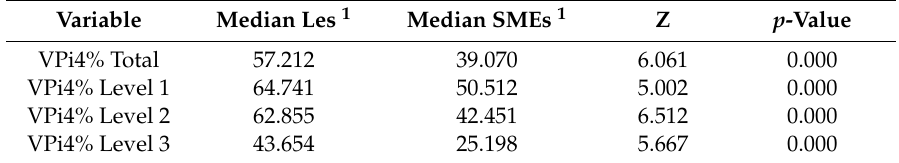
Table 7. Industry 4.0 index (VPi4) distribution, using Mann–Whitney–Wilcox test. Variable